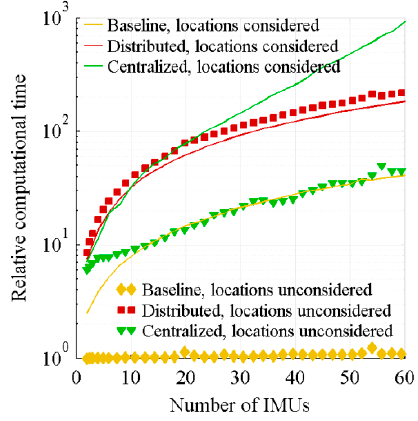
Figure 7. Standard deviation of the attitude rate estimation errors, with correlated and uncorrelated sensors bias, and function of the number of IMUs.